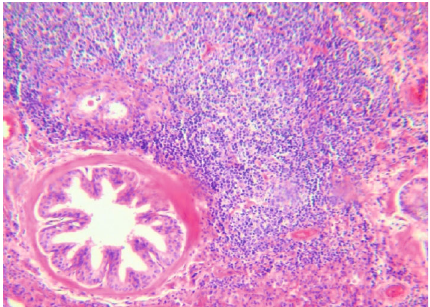
Figure 2: Ovine progressive pneumonia: peribronchiolar lymphoid hyperplasia with formation of prominent well-de fi ned lymphoid nodules and smooth muscle hyperplasia of the bronchiolar wall (H&E,